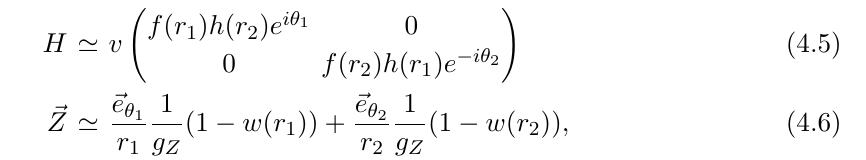
2 (solid line) ( Ψ 1 | |